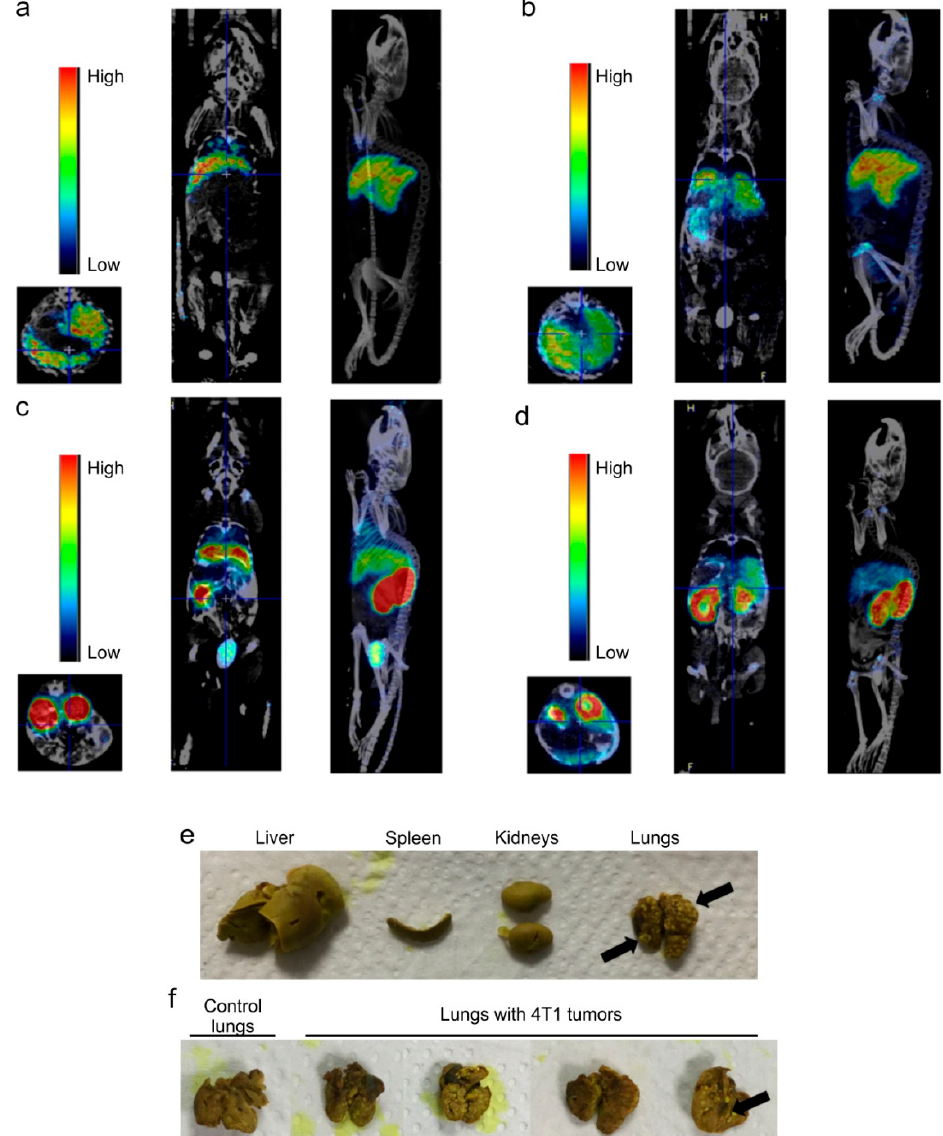
Figure 3. The biodistribution of Hb-DFO- 89 Zr complex in vivo. ( a , b ) Transverse plane, coronal plane and maximum intensity projection (MIP) of representative fused PET and CT images after intravenous injection of 0.03 mg of Hb-DFO- 89 Zr into healthy mouse; ( a ) shows signal detected 1 h after injection; high intensity signal from liver and low intensity signal from lungs; ( b ) shows signal detected 30 h after injection; high intensity signal from liver, reduction of signal from lungs. ( c , d ) Transverse plane, coronal plane and MIP of representative fused PET and CT images after intravenous injection of 0.09 mg of Hb-DFO- 89 Zr into tumor-bearing mouse; ( c ) shows signal detected 1 h after injection; high intensity signal was detected from kidneys and liver, low signal from lungs; ( d ) shows signal detected 39 h after injection; high intensity signal from kidneys, reduction of signal from liver and lungs. Radiotracer is eliminated and excreted with urine; color bars reflect radioactivity per volume. ( e ) Representative macroscopic images of liver, spleen, kidneys and lungs excised from mice that were inoculated with 4T1 cells nine days prior to organ collection. ( f ) Representative macroscopic images of lungs obtained from control mice and lung-tumor-bearing mice. Arrows indicate tumor nodules.